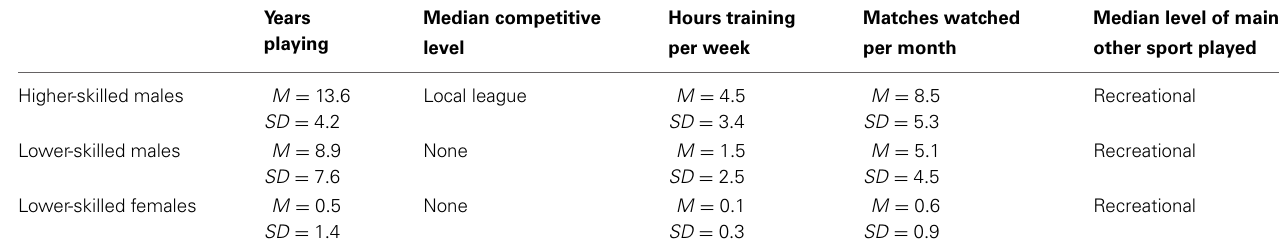
Table 1 | Comparison of the soccer experience of the participant